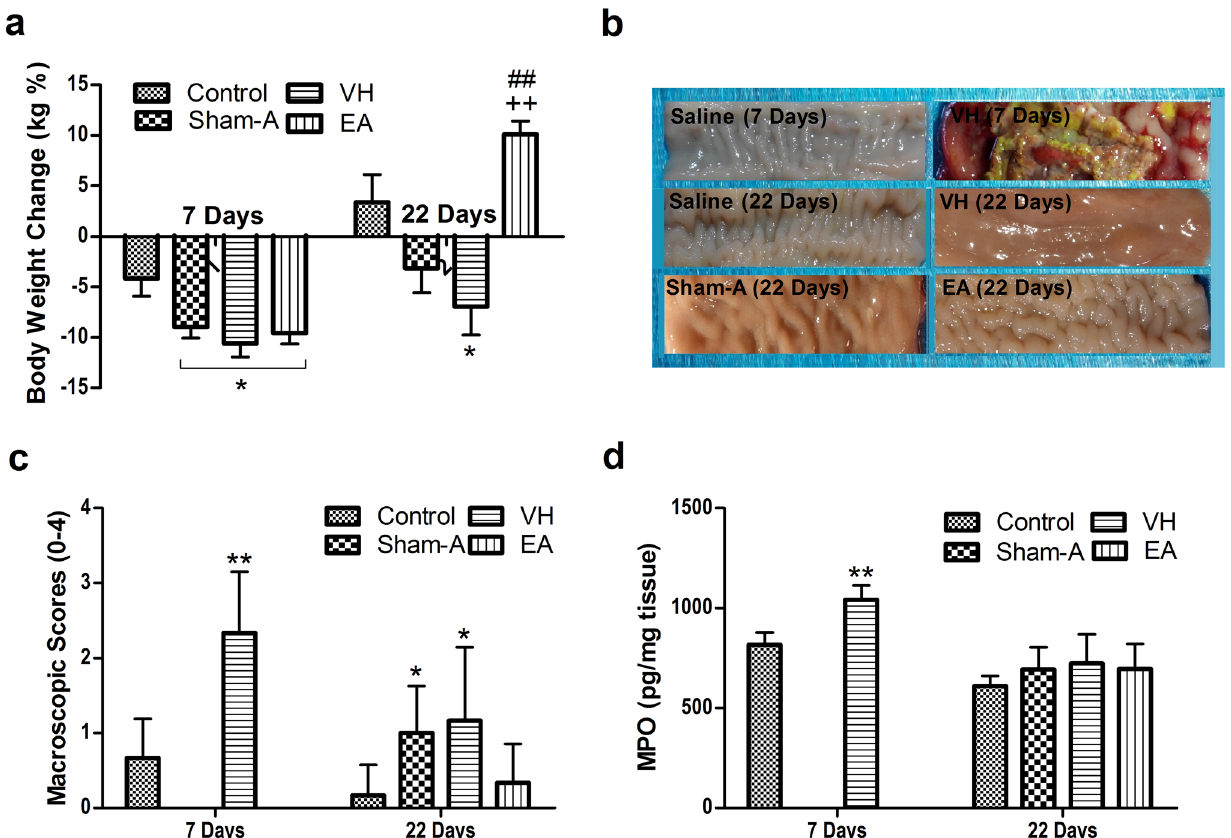
Figure 1. Effects of EA treatments on body weight, macroscopic pathologic changes and MPO concentrations in goats (mean ± SD). ( a ) Body-weight change. Body-weight changes were analyzed with one-way ANOVA [F (3, 32) = 5.380, P = 0.004] followed by Bonferroni’s post-hoc test ( P = 0.008, VH group vs. Control group; n = 12; P = 0.045, Sham-A vs. Control group, P = 0.049, EA group vs. Control group; n = 6). The goats of VH, Sham-A and EA groups exhibited lower body weight at 7 days. The VH group showed lower body weight than control goats at 22 days. EA-group gained body weight than those of VH or Sham-A group at 22 days. ( b ) Ileal histopathological changes. Ileal segments were incised longitudinally for macroscopic observation and representative images were taken from NaCl- and TNBS-treated goats on day 7 and from all groups on day 22. TNBS-injected ileum revealed hemorrhage, necrosis, edema, adhesion with its loop or mesentery, ulcerations and thickened wall only on day 7. ( c ) Ileal macroscopic scores. Macroscopic change scores were scored by two independent observers employing a 0–4 scale. Macroscopic change scores increased [ χ 2 (2) = 7.221, P = 0.007, df = 1 with a mean rank macroscopic scores of 12.75 for VH group, 3.83 for Control group] in the ileum of VH group on day 7 ( P = 0.007, n = 6). Similarly, Sham-A ( P = 0.026, n = 6) and VH-group ( P = 0.05, n = 6) showed higher macroscopic scores as compared to Control group on day 22. Kruskal–Wallis analysis followed by Mann– Whitney U-test. ( d ) Ileal myeloperoxidase (MPO) concentrations (mean ± SD, n = 6). MPO concentrations were analyzed with one-way ANOVA [F (1, 10) = 34.896, P = 0.000] followed by Independent t test ( P = 0.000). TNBS-injected ileal samples displayed markedly higher MPO concentrations only on day 7. ** P < 0.01; * P < 0.05, VH/Sham-A/EA group versus Control group; ++ P < 0.01, VH group versus Sham-A group; ## P < 0.01, VH group versus EA